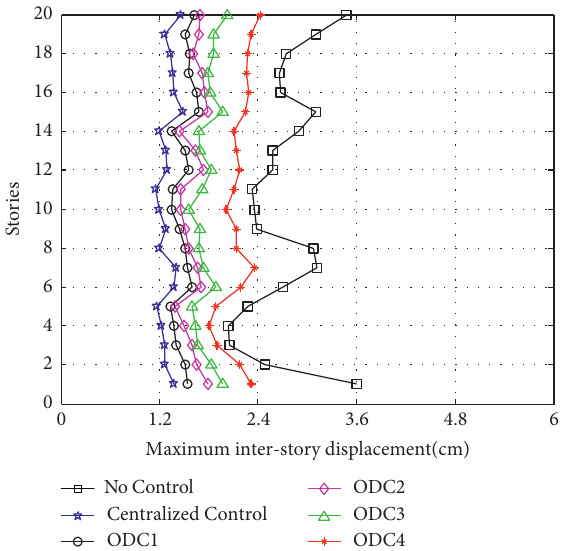
Figure 7: The maximum singular values of time delay τ � 40ms.